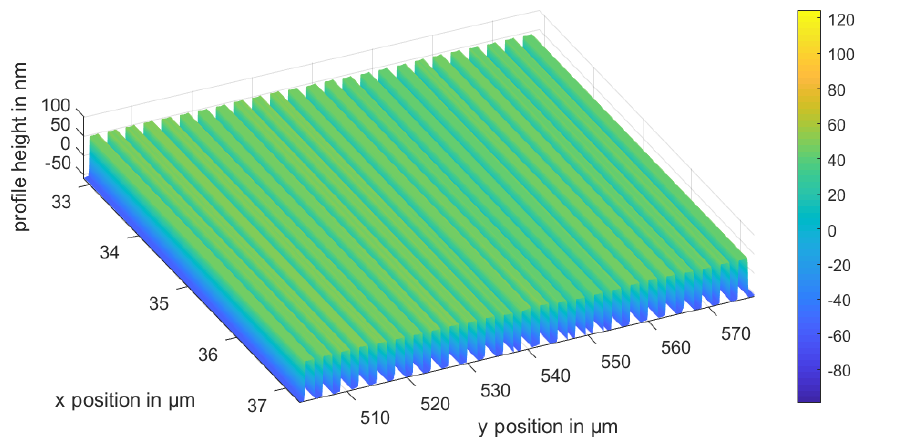
Figure 11. Section from the scanned area of TGZ2.